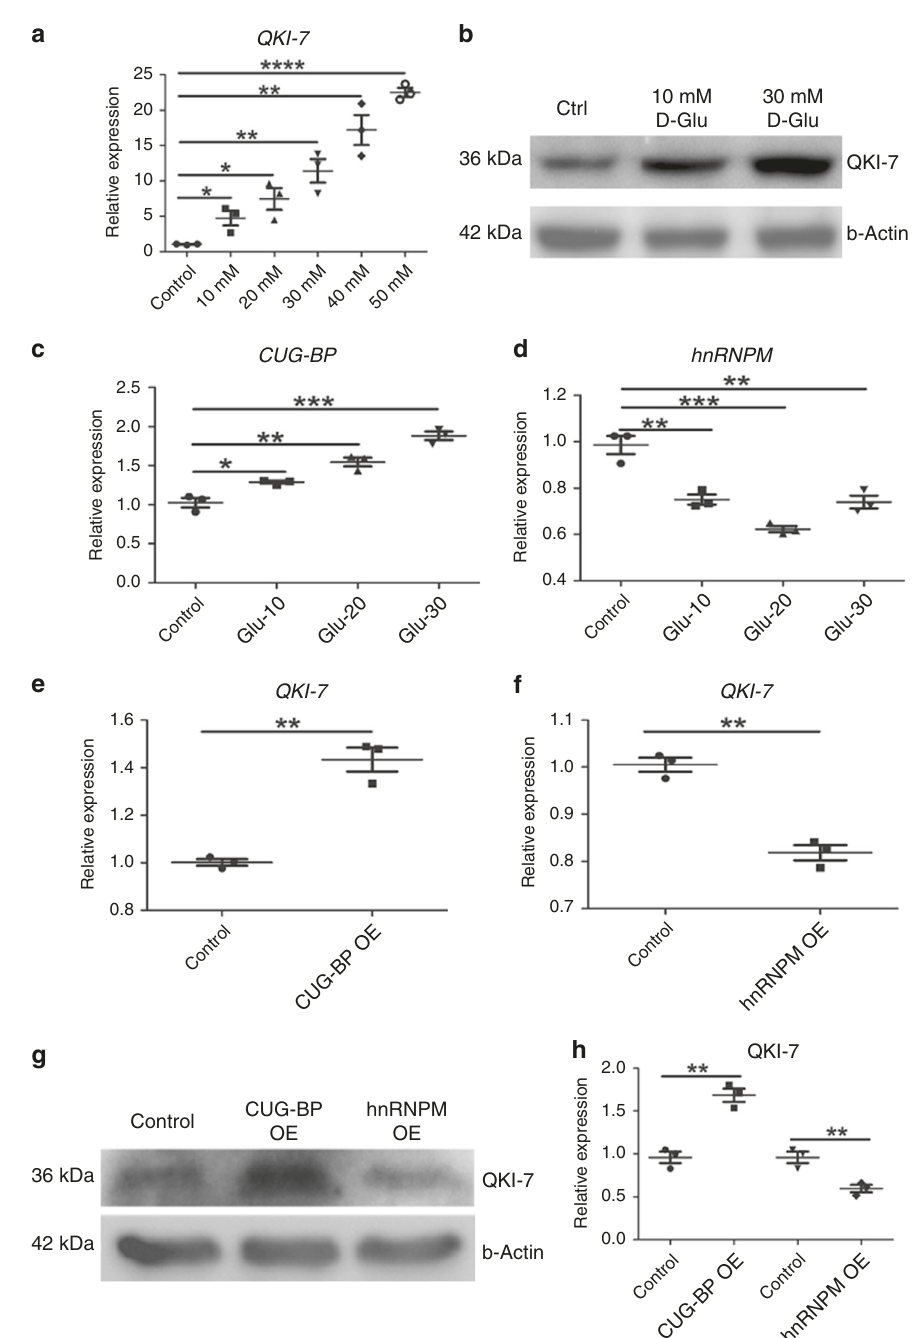
Fig. 1 QKI-7 dynamics under high glucose related to CUG-BP and hnRNPM. Upon high-glucose treatment of miPS-ECs, QKI-7 expression showed a dose- dependent increase at both mRNA ( p values: 0.023, 0.013, 0.0034, 0.0016, and <0.0001) and protein levels ( a , b ). CUG-BP was upregulated by high- glucose treatment dose-dependently ( p values: 0.013, 0.0032, 0.0004) ( c ). hnRNPM expression was downregulated by high-glucose treatment ( p values: 0.0064, 0.001, 0.0069) ( d ). CUG-BP overexpression enhanced QKI-7 expression ( p value: 0.0012) ( e ). hnRNPM overexpression suppressed QKI-7 expression ( p value: 0.0011) ( f ). QKI-7 upregulation by overexpressed CUG-BP and downregulation by ectopic hnRNPM is shown by western blot ( g ) and quanti fi ed in ( h ) ( p values: 0.0021, 0.0099). L-glucose-treated cells have been used as controls in these experiments. Data are from three biologically independent experiments. Error bars represent mean ± SEM ( n = 3). P values are shown: * p < 0.05, ** p < 0.01, *** p < 0.001, **** p < 0.0001 (two-tailed t test). The source data are provided as a Source data fi